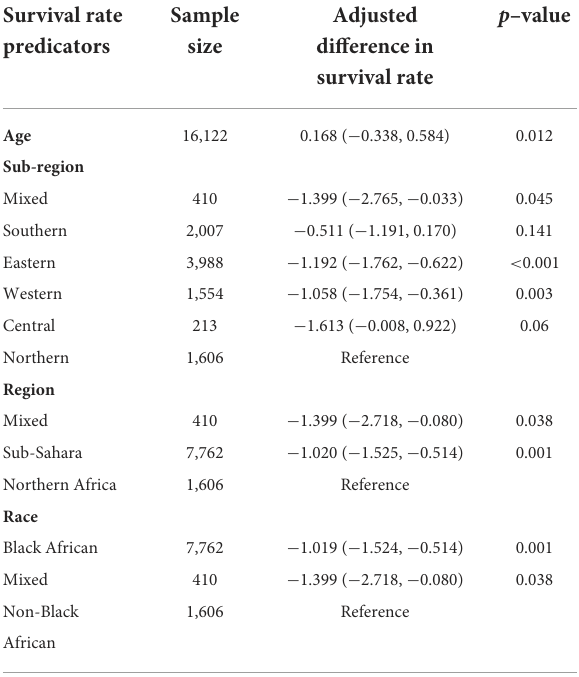
TABLE 3 Meta-regression analysis of gender, age, and